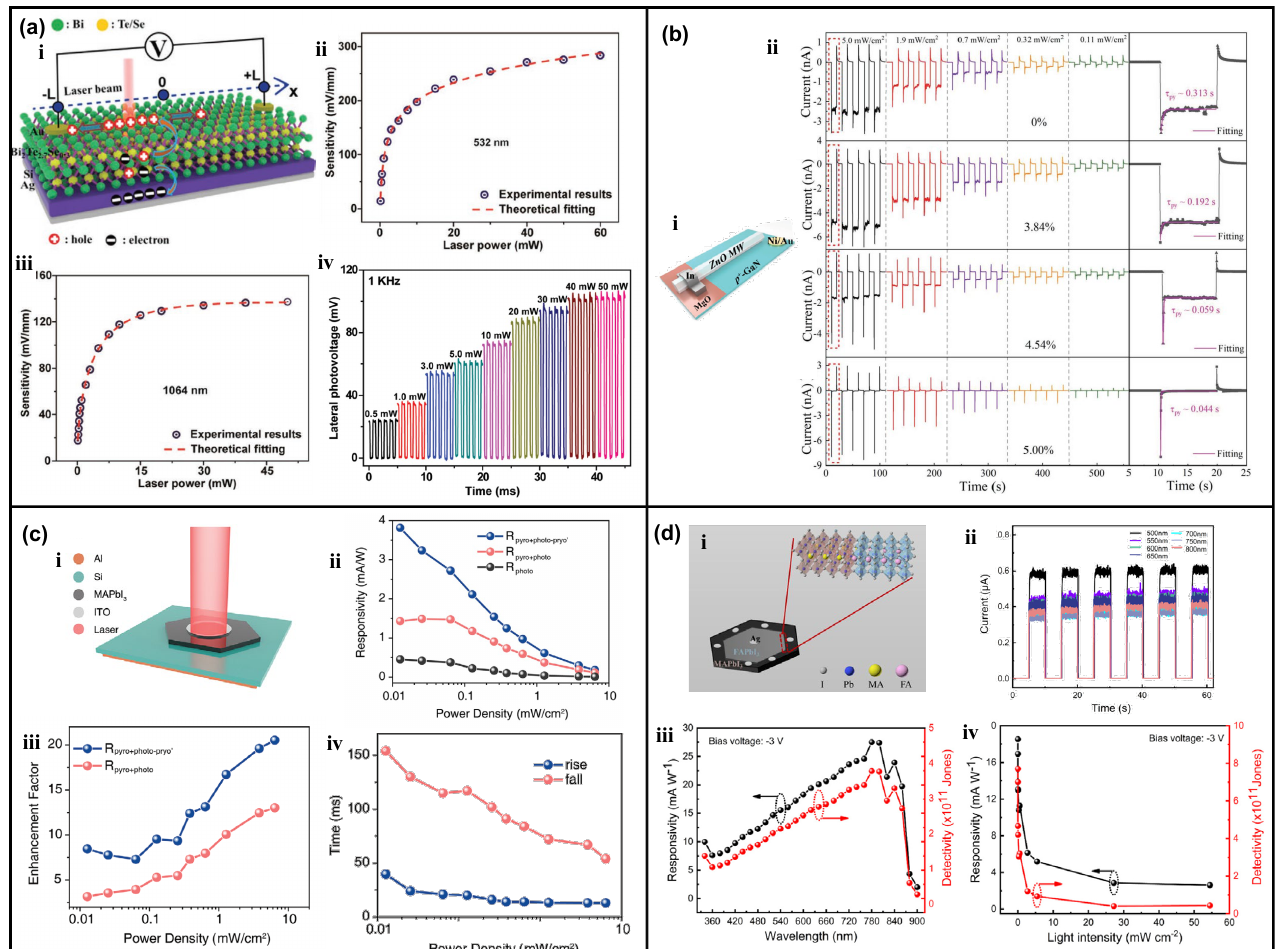
Figure 10. ( a ) Ultraband, large sensitivity position detector based on a Bi 2 Te 2.7 Se 0.3 /Si heterojunction. ( ⅰ ) Schematic illustration of the lateral photovoltaic effect in the Bi 2 Te 2.7 Se 0.3 /Si heterojunction; ( ⅱ , ⅲ ) The extracted power-dependent sensitivities for 532 and 1064 nm; ( ⅳ ) T-LPV curves of different powers illumination. Reproduced with permission from [82]. Copyright 2019 Wiley; ( b ) Schematic diagrams and I–t curves of MW/p + -GaN photodetectors under UV 370 nm illumination with different light intensities, in which the MWs contain different Ga doping concentrations. Reproduced with permission from [83]. Copyright 2022 Wiley; ( c ) MAPbI 3 /Si heterojunction photodetector. ( ⅰ ) Schematic diagram showing the structure of MAPbI 3 /Si heterojunction; ( ⅱ , ⅲ , ⅳ ) Corresponding R pyro + photo-pyro’ , R pyro + photo , and R photo , enhancement factor for (R pyro + photo-pyro’ )/R photo and R pyro + photo /R photo and rise time and fall time as a function of the power density. Reproduced with permission from [85]. Copyright 2021 Wiley; ( d ) The α -FAPbI 3 /MAPbI 3 SC concentric annular lateral heterojunction pho- todetector. ( ⅰ ) Schematic of the α -FAPbI 3 /MAPbI 3 SCs concentric annular lateral heterojunction pho- todetector; ( ⅱ ) Time-dependent photoresponse under light illumination (0.19 mW/cm 2 ) ranging from 500 nm to 800 nm at 3 V bias; ( ⅲ ) Spectral responsivity and detectivity characteristics of the α - FAPbI 3 /MAPbI 3 SC concentric annular lateral heterojunction photodetector with irradiance wave- length ranging from 340 to 900 nm under 3 V bias; ( ⅳ ) Responsivity and detectivity as a function of incident light intensity. Reproduced with permission from [86]. Copyright 2022 Royal Society of Chemistry.